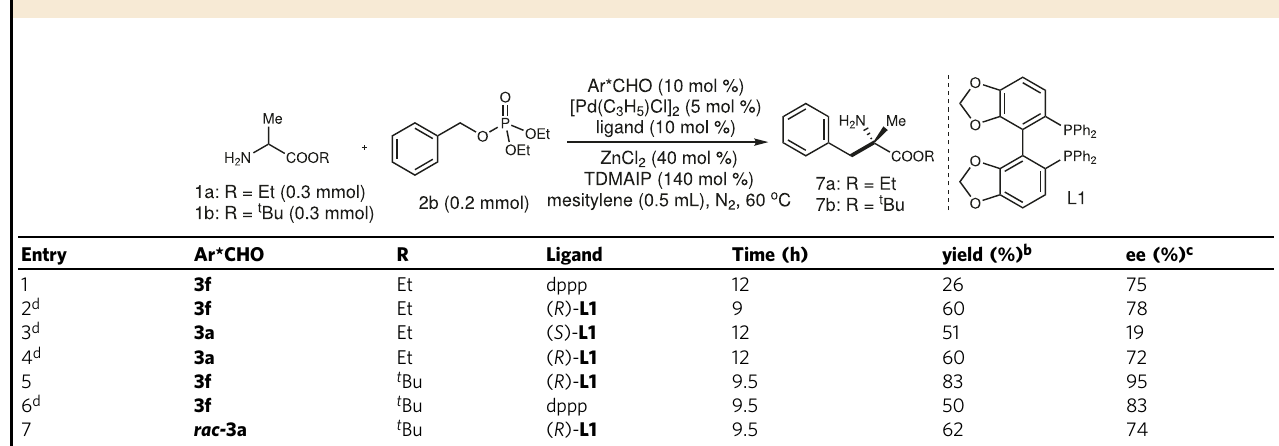
Table 2 Reaction optimization of monocyclic benzyl alcohol involved benzylation reaction a